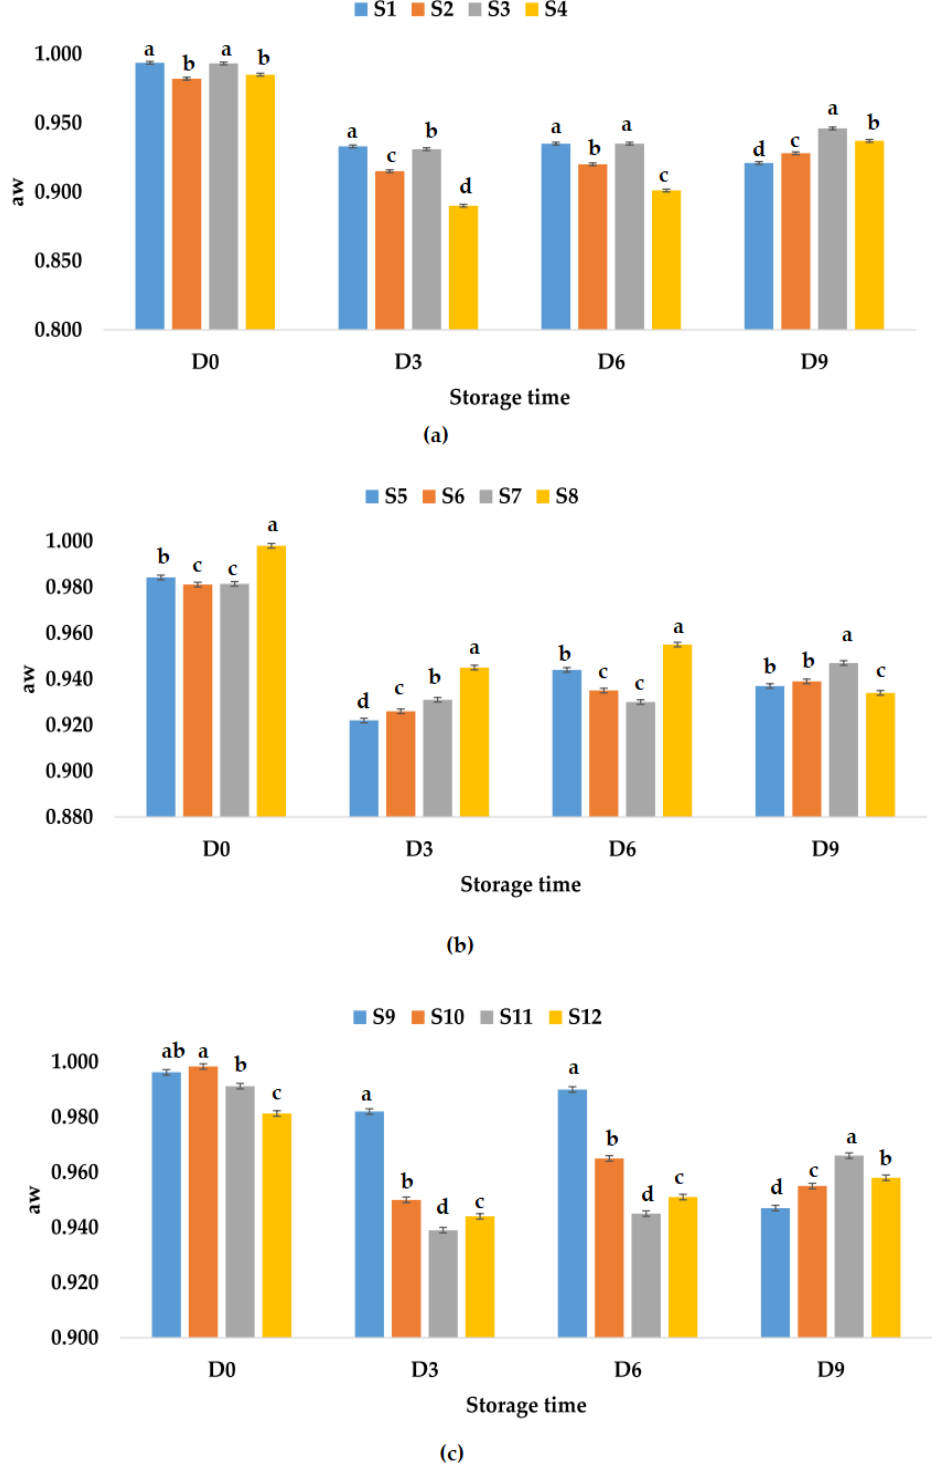
Figure 3. Variation in aw of juice samples during storage period (D-day) at refrigeration temperature (4 °C): ( a ) apple juice samples (S1, S2, S3, S4); ( b ) apple and pumpkin juice samples (S5, S6, S7, S8); ( c ) apple and pomegranate juice samples (S9, S10, S11, S12). Means with different lowercase letter indicate the significant differences ( p < 0.05) among the samples and were performed separately for each day of storage.